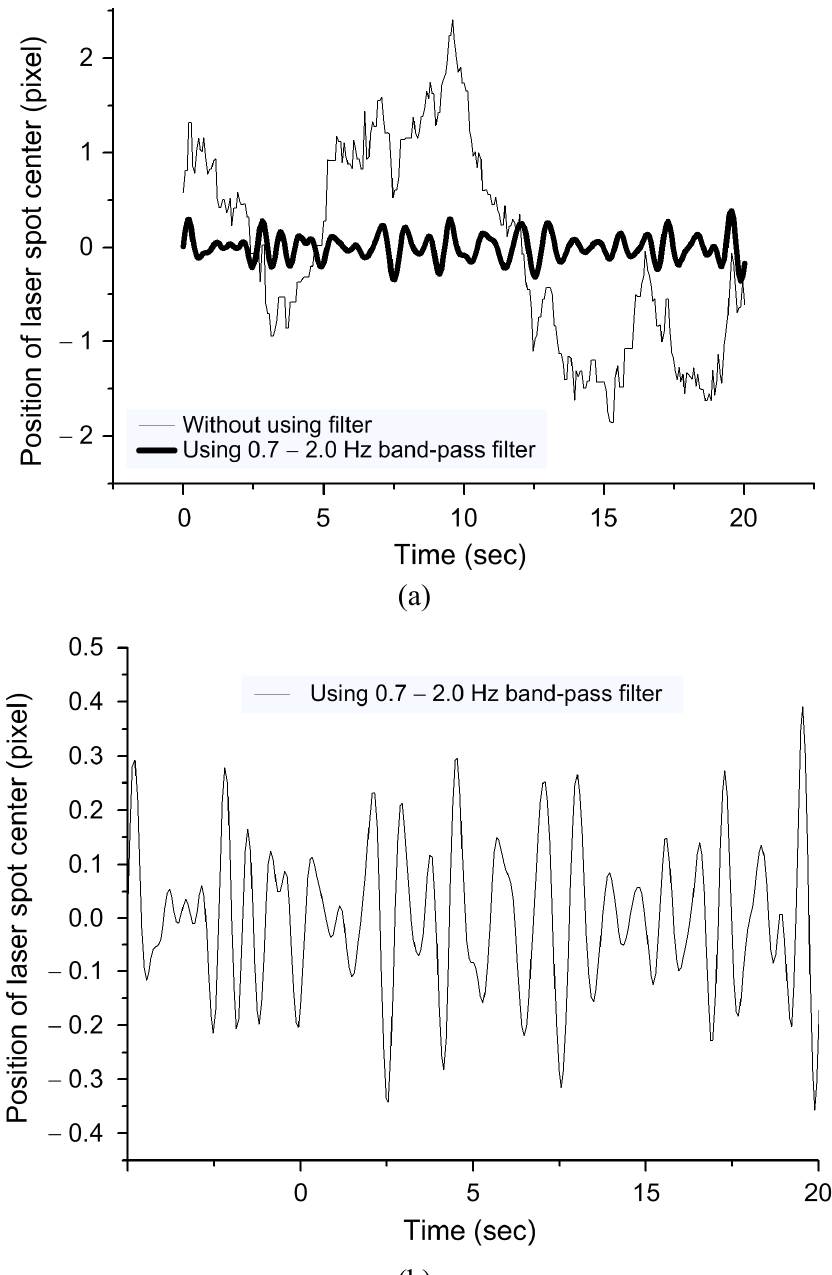
Figure 9. Laser spot centers measured by APM system: (a) the original data of centroid variation of laser spot center and (b) the data after enlarged amplitude scale and with